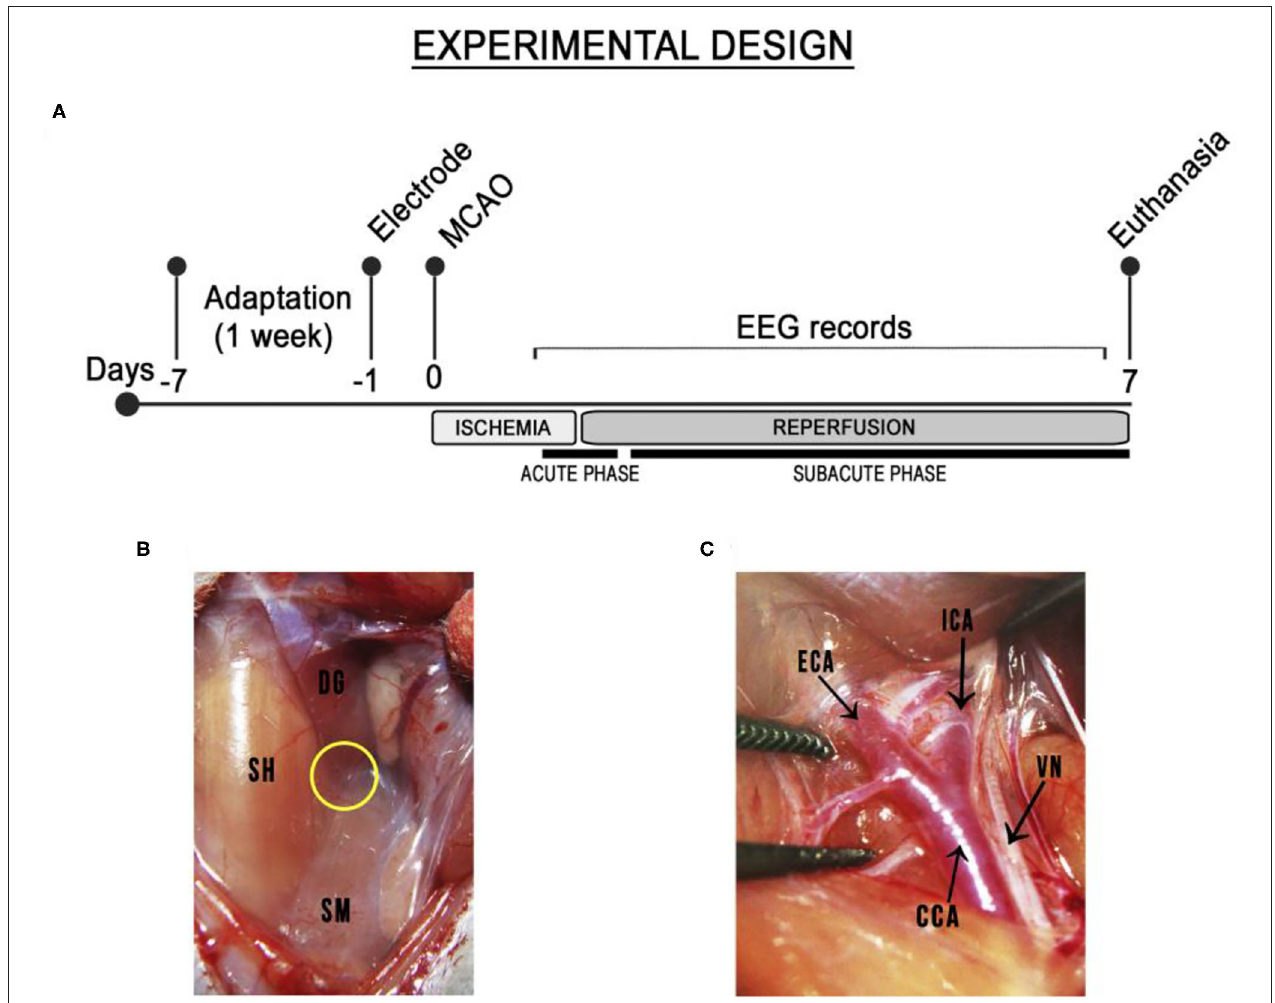
FIGURE 1 | Schematic diagram of the timeline of the transient ischemic stroke and the middle cerebral artery occlusion surgery. (A) Experimental design. Electrode: implantation of electrodes. MCAO: middle cerebral artery occlusion. Ischemia: animals submitted to MCAO for 30min. Reperfusion: reperfusion monitored for 7 days after the MCAO. (B) Insertion point among the three muscles (yellow circle): the sternohyoid (SH), medial to incision; the digastric (DG), identified by its shiny white portion), and the sternomastoid muscle (SM). (C) The common, external, and internal carotid arteries (CCA, ECA, ICA) were exposed and the vagus nerve (VN) was dissected carefully from the common and internal carotid